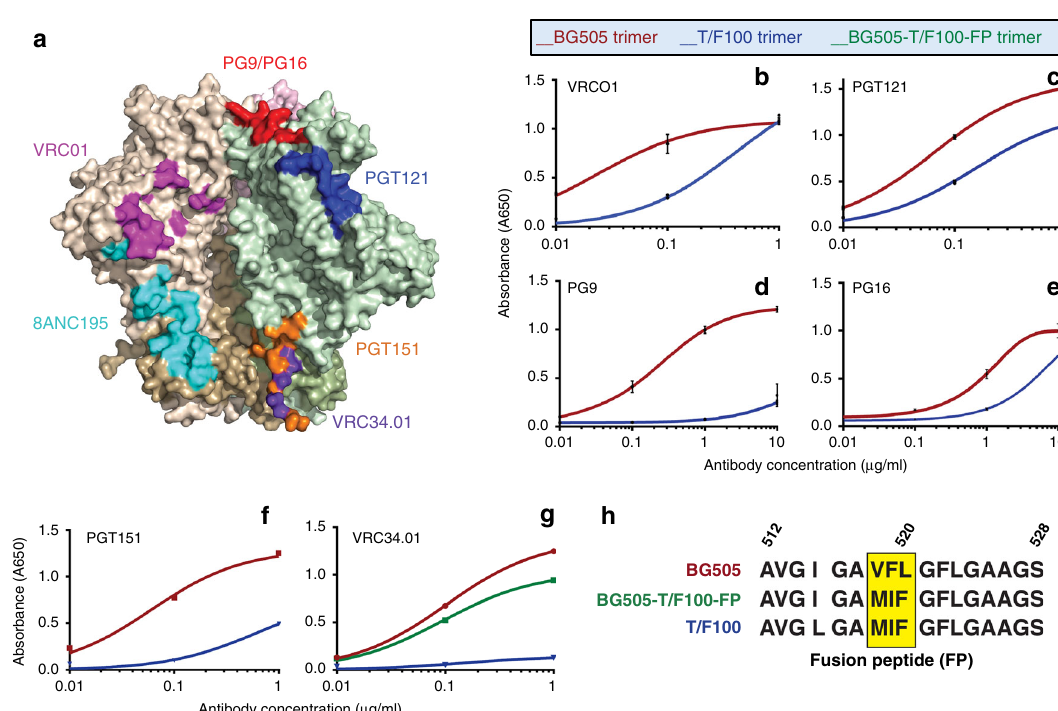
Fig. 4 Antigenicity of the T/F100 trimer. a Epitope regions recognized by different bNAbs are shown on a surface-view structural model of BG505 gp140 trimer (PDB: 5I8H). Each protomer of the trimer are shown in different colors: brown, green, or pink. The gp120 and gp41 subunits of each protomer are shown in light and dark shades of the same color, respectively. b – g Binding curves of T/F100 (blue curve) and BG505 (red curve) trimers with bNAbs VRCO1 ( b ), PGT121 ( c ), PG9 ( d ), PG16 ( e ), PGT151 ( f ), and VRC34.01 ( g ), as determined by ELISA. Also shown in ( g ) is binding of BG505-T/F100-FP trimer to VRC34.01 (green curve). h Alignment of the fusion peptide sequences (amino acids 512 – 528) at the N-terminus of the gp41 subunit of BG505, BG505-T/F100FP, and T/F100 trimers. The three amino-acid residues that were swapped in BG505 trimer by the respective residues of T/F100 trimer to generate the BG505-T/F100FP mutant trimer are highlighted in yellow. ELISAs were performed using puri fi ed trimers coated on Strep-Tactin plates. Each binding curve was generated using data from three independent experiments. The trimer concentration was kept constant at 1 µ g/ml and the bNAb concentration was varied as shown. Results shown are representative of at least three independent experiments performed in triplicates. The P value as determined by the unpaired two-tailed t test is 0.0006 for VRC01 at 0.1 μ g/ml of antibody, < 0.0001 for PGT121, PG9 and PGT151, 0.0036 for PG16, and 0.0003 for VRC34.01 at 1 μ g/ml of antibody. Error bars denote the standard